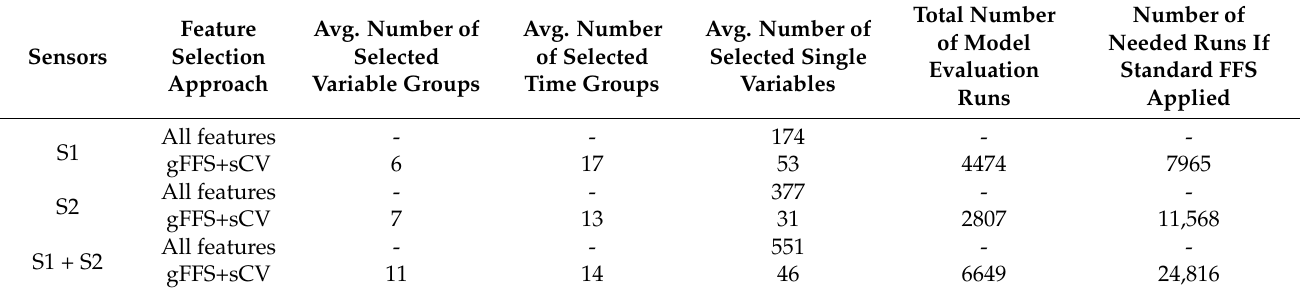
Table 3. The average number of selected single features or feature groups using 3-step group-wise Forward Feature Selection (gFFS) and the corresponding total number of model evaluation runs.